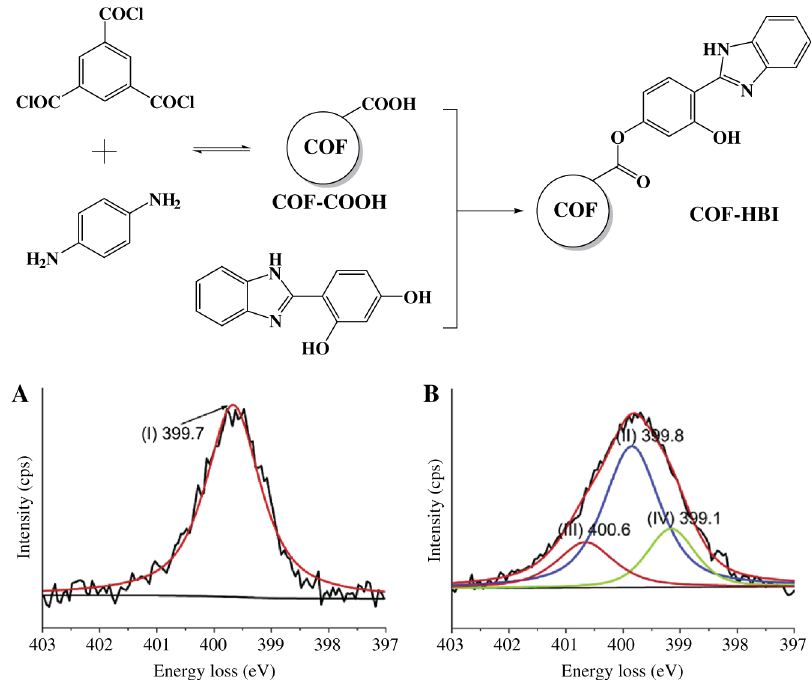
Figure 4: Preparations and N1s XPS spectra of COF-COOH and